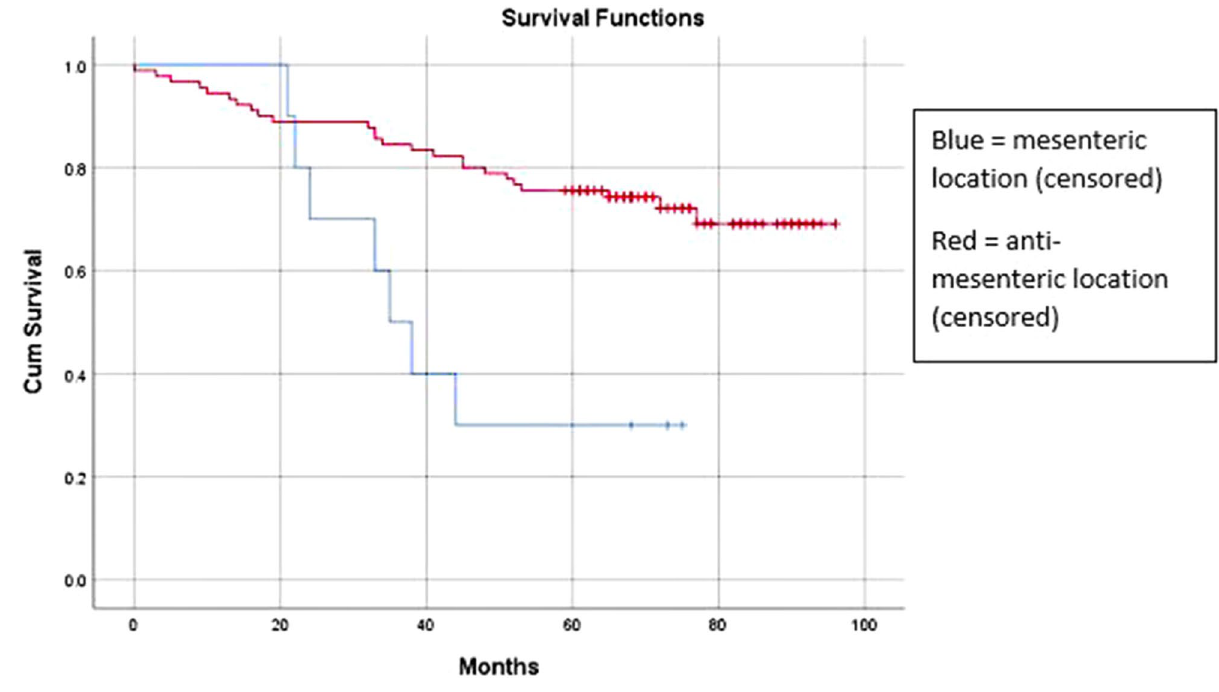
Figure 3. Kaplan–Meier survival